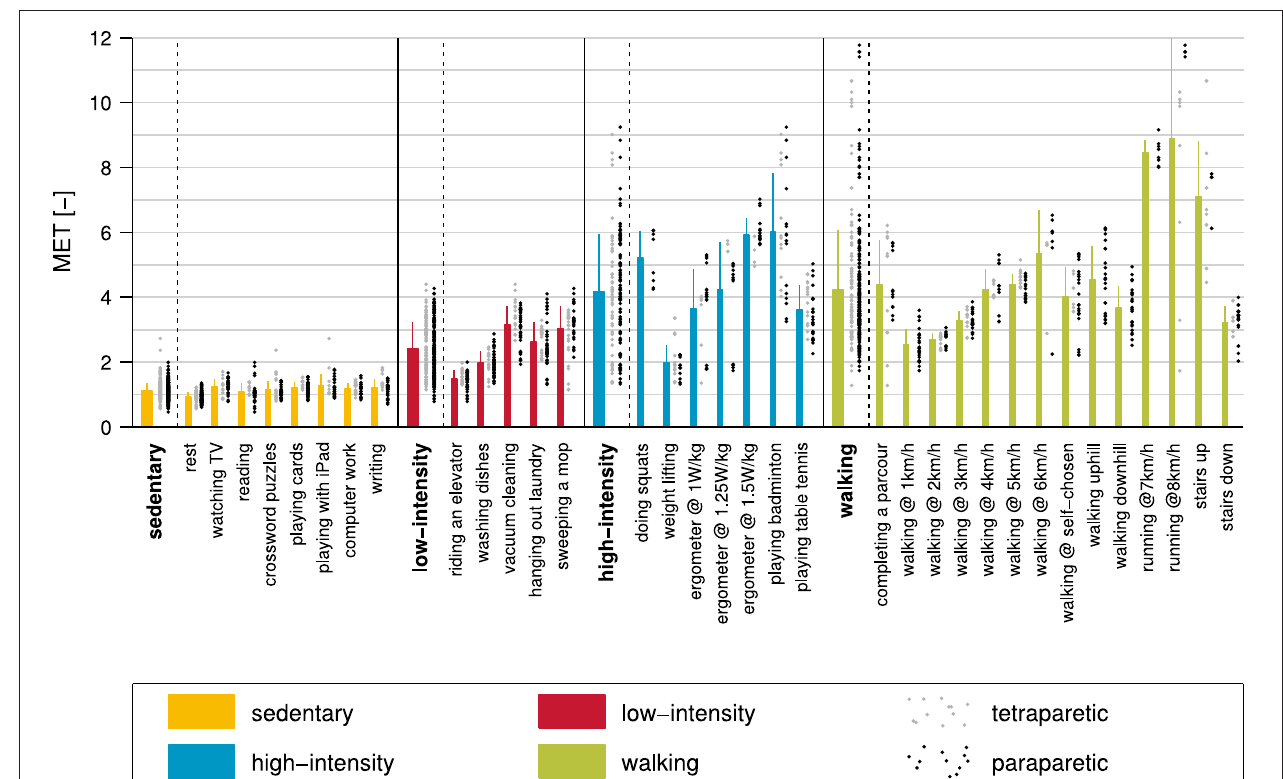
FIGURE 5 | The measured metabolic equivalent of task (MET) for all activities and activity classes included in this study. The different bars represent the mean ± standard deviation and the single values for paraparetic and tetraparetic participants are presented in black and gray,